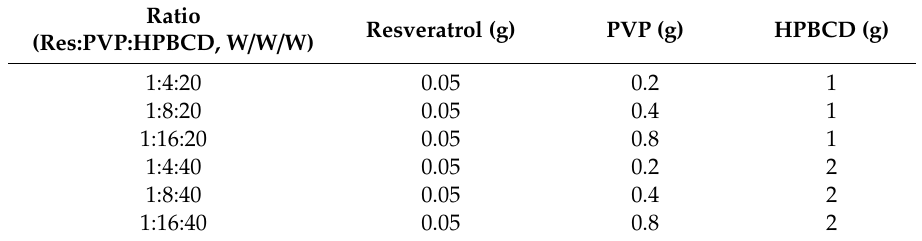
Amounts of resveratrol, PVP and HPBCD in di ff erent ratio formulations of resveratrol